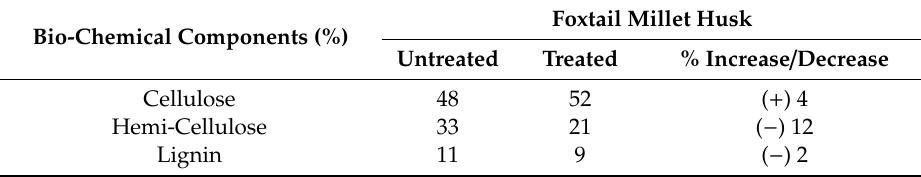
Table 1. Bio-chemical components of untreated (6% concentrated NaOH treated for 4 h) and treated foxtail millet